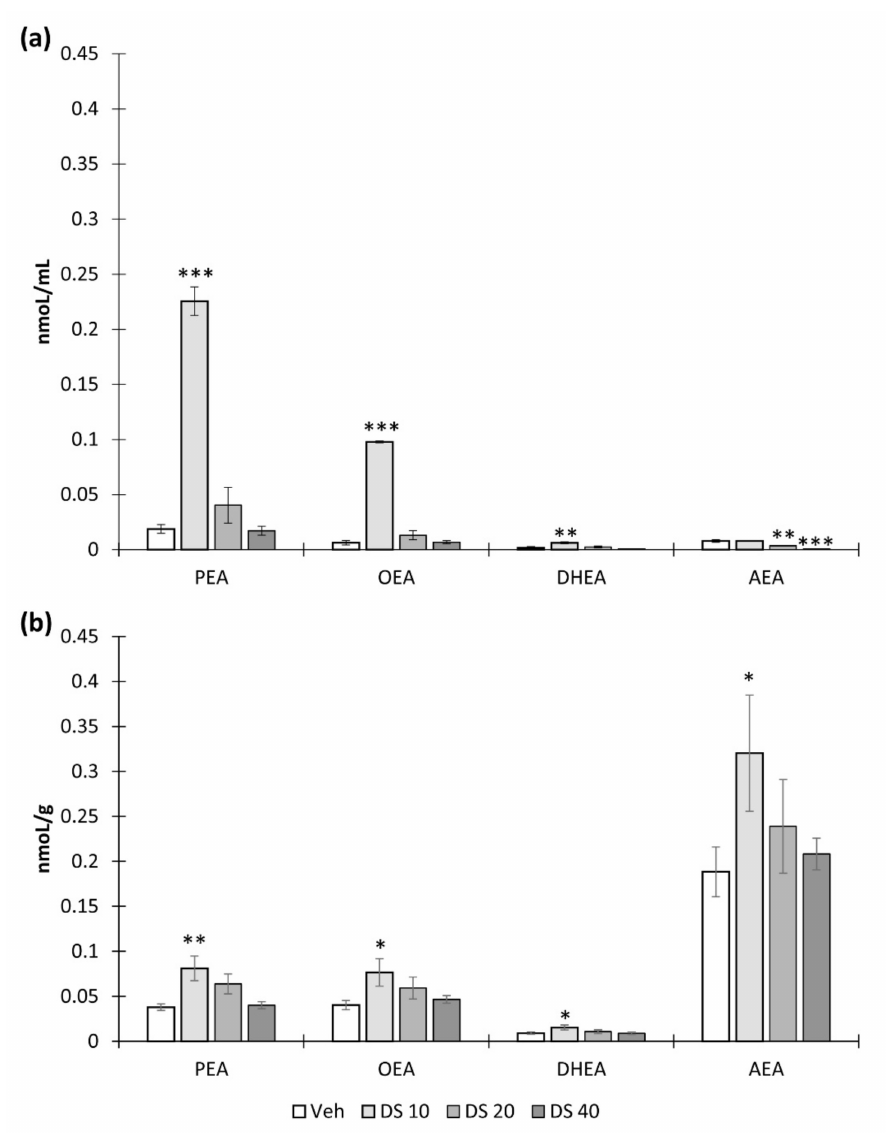
Figure 4. Effect of DS in doses 10, 20, and 40 mg/kg administered for 7 consecutive days on N -acylethanolamines concentration in plasm ( a ) and brain ( b ). Mean ± SEM, n = 8 (number of animals per group). One-way ANOVA with post hoc Tukey test, * p < 0.05, ** p < 0.01, *** p < 0.001, *—compared to